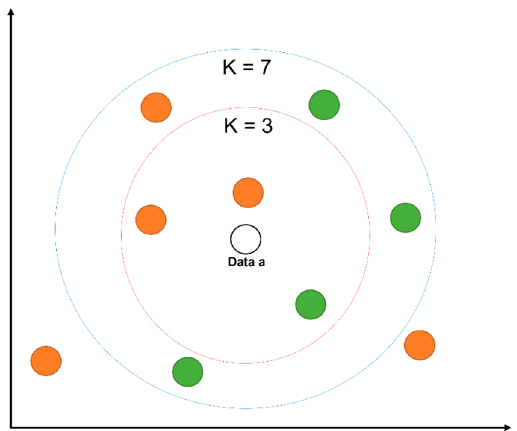
Figure 10. Classification results using K-nearest neighbor algorithm.